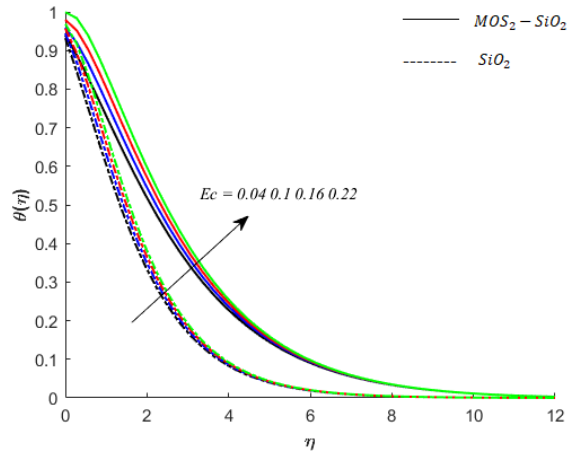
Figure 7. Influence of Ec on temperature when M = 0.9, Pr = 0.9, Sc = 0.8,K = 0.1, Ei = 0.1, Bi = 0.05, β ∗ = 0.1, γ = 0.1, γ 1 = 0.1. Temperature of fluid particles and Biot number: The Biot number 𝐵 (cid:3036) appears in the dimensionless form of convective boundary conditions. The role of 𝐵 (cid:3036) on the temperature of fluid particles of 𝑀𝑜𝑆 (cid:2870) − 𝑆𝑖𝑂 (cid:2870) − 𝐶𝑎𝑠𝑠𝑜𝑛 𝑓𝑙𝑢𝑖𝑑 is examined. The comparative analysis between the role of 𝐵 (cid:3036) on temperatures of 𝑆𝑖𝑂 (cid:2870) − 𝐶𝑎𝑠𝑠𝑜𝑛 𝑓𝑙𝑢𝑖𝑑 given by Figure 8. In both types of fluids (mono-nanofluid and hybrid nanofluid), temperature fluid particles have an increasing behavior for Biot number 𝐵 (cid:3036) . Figure 8. Influence of 𝐵𝑖 on temperature when 𝑀 = 0.9, 𝑃𝑟 = 0.9, 𝐸𝑐 = 0.2, 𝑆𝑐 = 0.8, 𝐸𝑖 = 0.1, 𝐾 = 0.1, 𝛽 ∗ = 0.1, 𝛾 = 0.1, 𝛾 = 0.1 . (cid:2869)